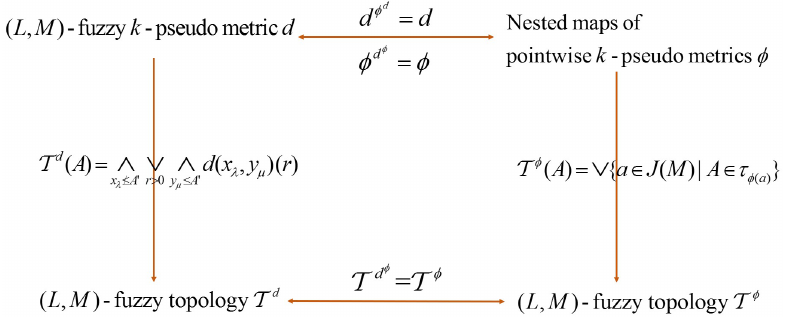
Figure 2. The ( L , M ) -fuzzy topology T d φ = T φ